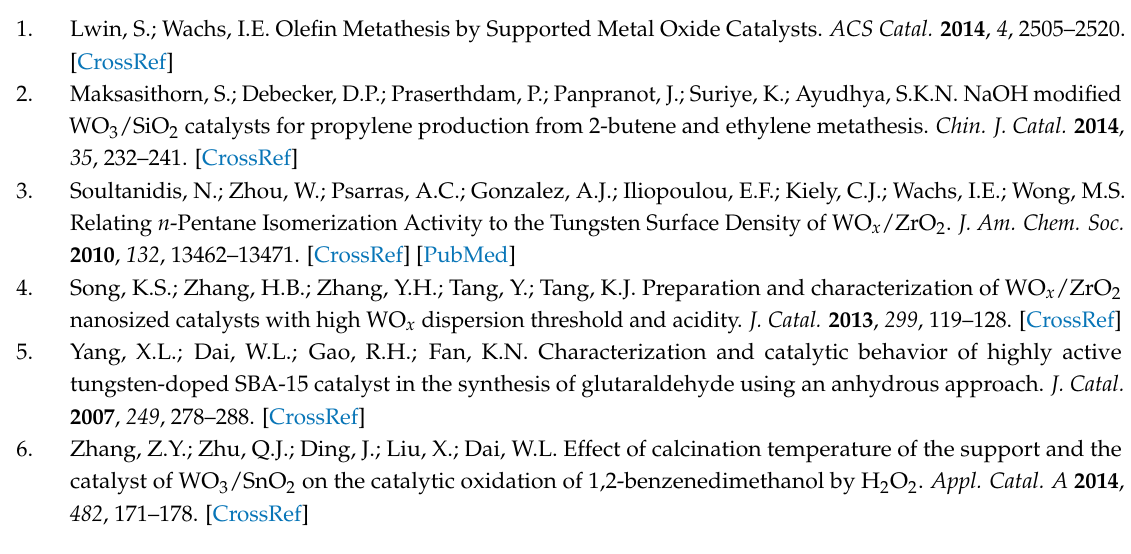
Figure S1: FT-IR spectra of various samples: (a) UiO-66; (b) 40 wt % WO 3 /UiO-66; (c) 5 wt % B 2 O 3 -40 wt % WO 3 ; (d) 10 wt % B 2 O 3 -40 wt % WO 3 ; (e) 15 wt % B 2 O 3 -40 wt % WO 3 ; (f) 20 wt % B 2 O 3 -40 wt % WO 3 /UiO-66; (g) 15 wt % B 2 O 3 -40 wt % WO 3 after the sixth reaction cycle., Table S1: Comparison of catalytic performance in the selective oxidation of CPE over various